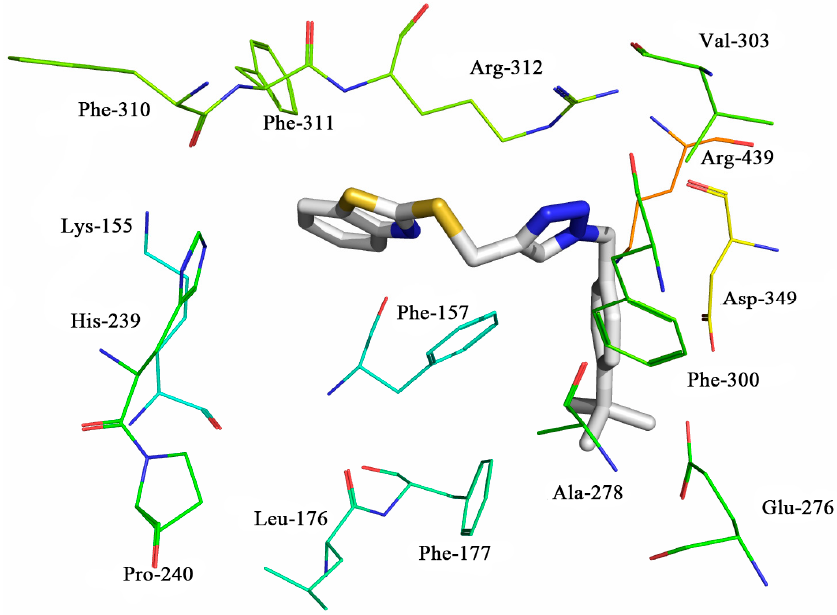
Figure 2. Compound 6i was docked to the binding pocket of the Saccharomyces cerevisiae α